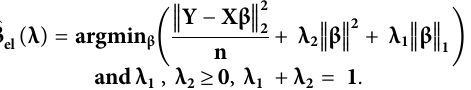
Frontiers in Genetics |